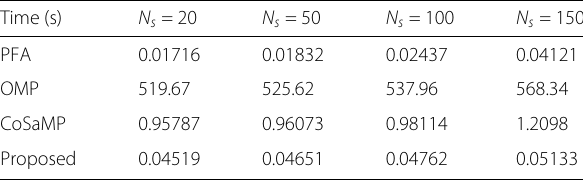
Table 1 Average running time of imaging algorithms versus different SNRs